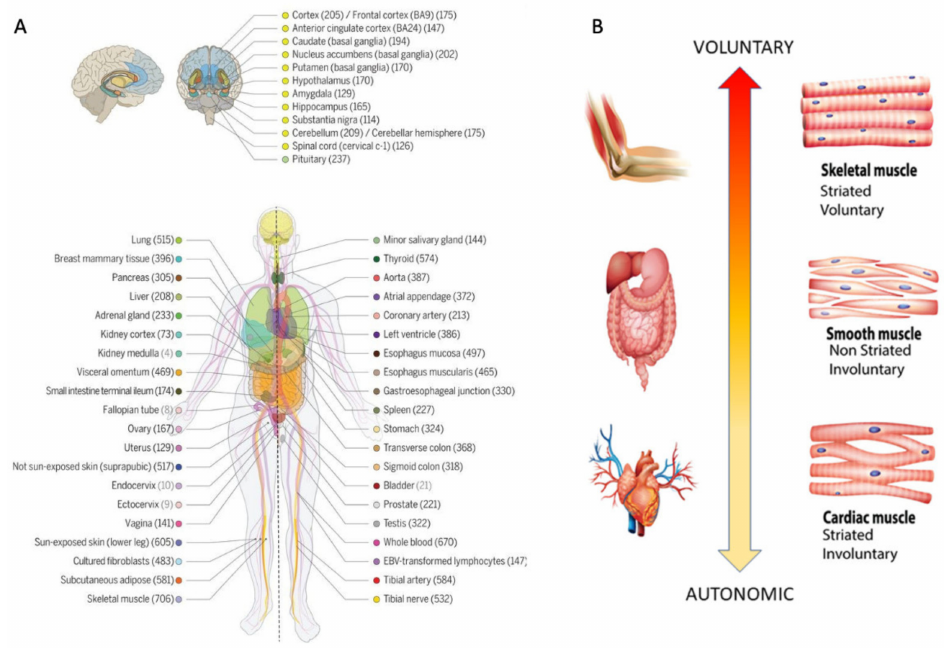
Figure 2. Genomic and Physiological criteria used in this study. ( A ) GTEx v8 study atlas of 54 tissues including 11 distinct brain regions and two cell lines. Genotyped sample donors’ numbers in parenthesis and color coding to indicate the tissue in the adjacent circles (Reprinted with permission types of muscles supporting autonomic, involuntary and voluntary actions in humans can help us categorize behavioral functional levels according to related tissues affected